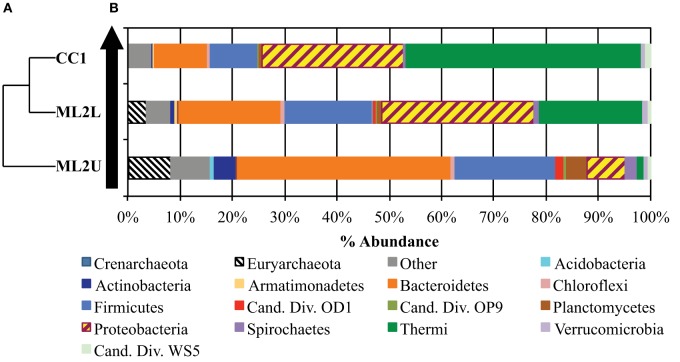
(A) UPGMA-clustered dendrogram demonstrates relatedness between samples. (B) Histogram of OTUs present at least 50 times in the OTU table, separated by phylogenetic assignment to the Phylum level. The black arrow represents direction of flow in the seep.